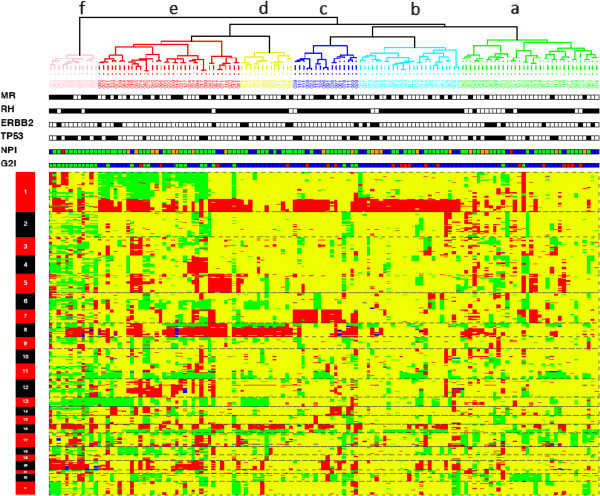
tumoral classification according to array CGH genomic profile. Unsupervised hierarchical clustering using genomic copy number variation enables the classification of the 135 breast carcinomas into six branches. MR, black: metastatic relapse; HR, black: positive for steroid hormonal receptors; Her2, black: Her2 score 3+; p53, black: TP53 mutation or protein overexpression; NPI (Nottingham prognostic index) red: NPI-1, blue: NPI-2, green: NPI-3, orange: NPI-4; G2I (genomic instability index) red: G2I-1, blue: G2I-2, green: G2I-3.